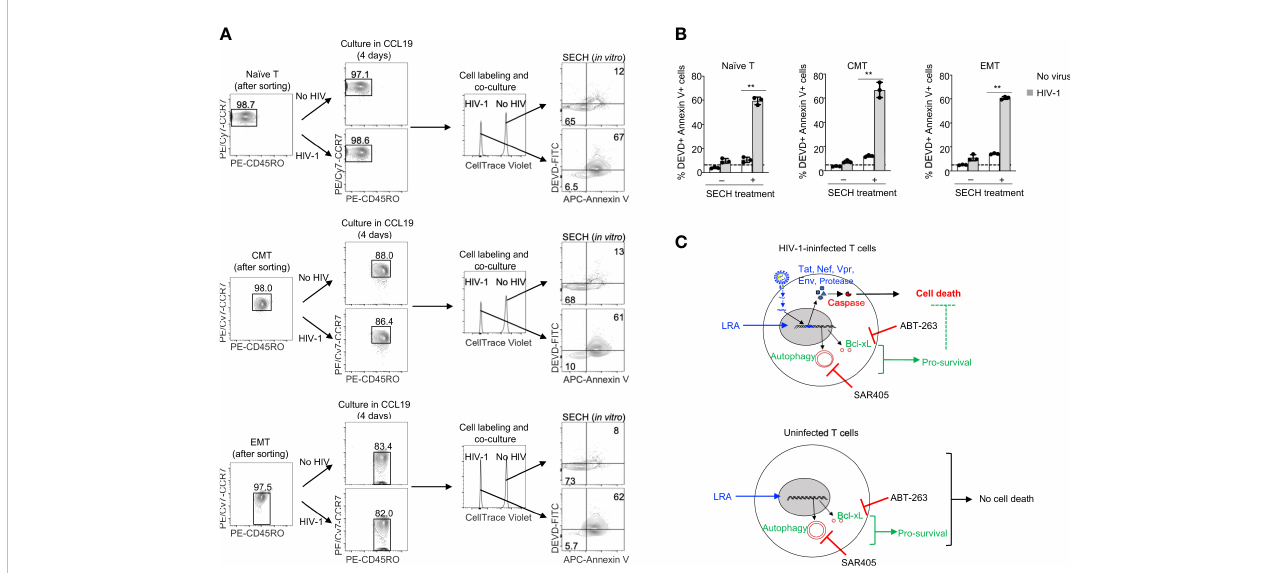
FIGURE 5 Speci fi city in the killing of HIV-1-infected naïve T cells, CMT and EMT, but not uninfected bystander cells. (A, B) HIV-1 latent infection was established in naïve T cells, CMT and EMT as in Figure 4, and mixed with CellTrace Violet-labeled uninfected counterparts. Cells were cultured with SECH components (IDB, ABT-263 and SAR405) in the presence of BMS-626529 as indicated for 48 h. The cells were then stained with DEVD-FITC and APC-Annexin V, and analyzed by fl ow cytometry (A) . Percentages of DEVD-FITC + Annexin V + cells were quanti fi ed (B) . Data represent biologically replicates and are presented as mean ± SD. Comparison with uninfected cells: ** P <0.01. (C) Viral reactivation with LRAs can induce the expression of HIV-1 components that trigger apoptosis. However, LRAs simultaneously upregulate pro-survival autophagy and anti-apoptotic molecules that counteract viral product- induced cell death, resulting in incomplete killing of HIV-1-infected cells. Inhibiting pro-survival autophagy and anti-apoptotic molecules allows viral products to induce high levels of cell death after treatments with LRAs. In uninfected bystanders, upregulation of pro-survival autophagy and anti- apoptotic molecules by IDB would confer protection against cell